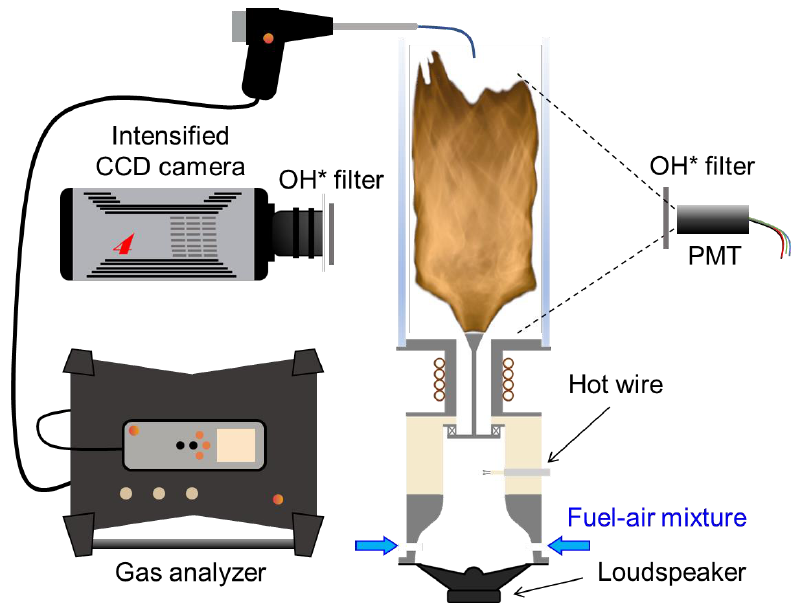
Figure 2. Schematic representation of the experimental setup with diagnostics.